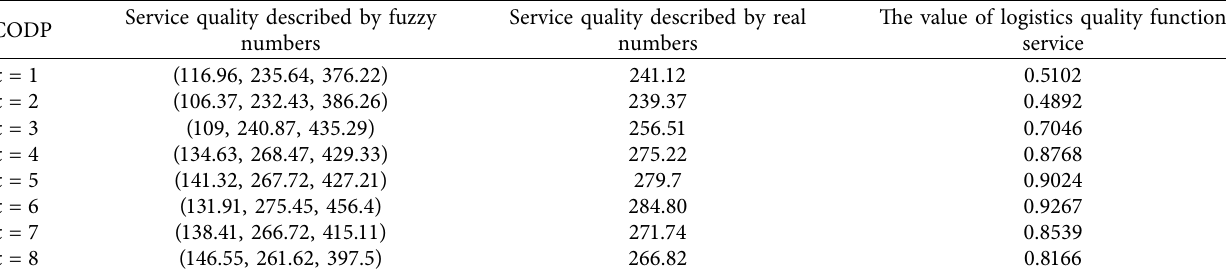
Figure 7: Logistics service quality function. Table 8: Calculation results of logistics service